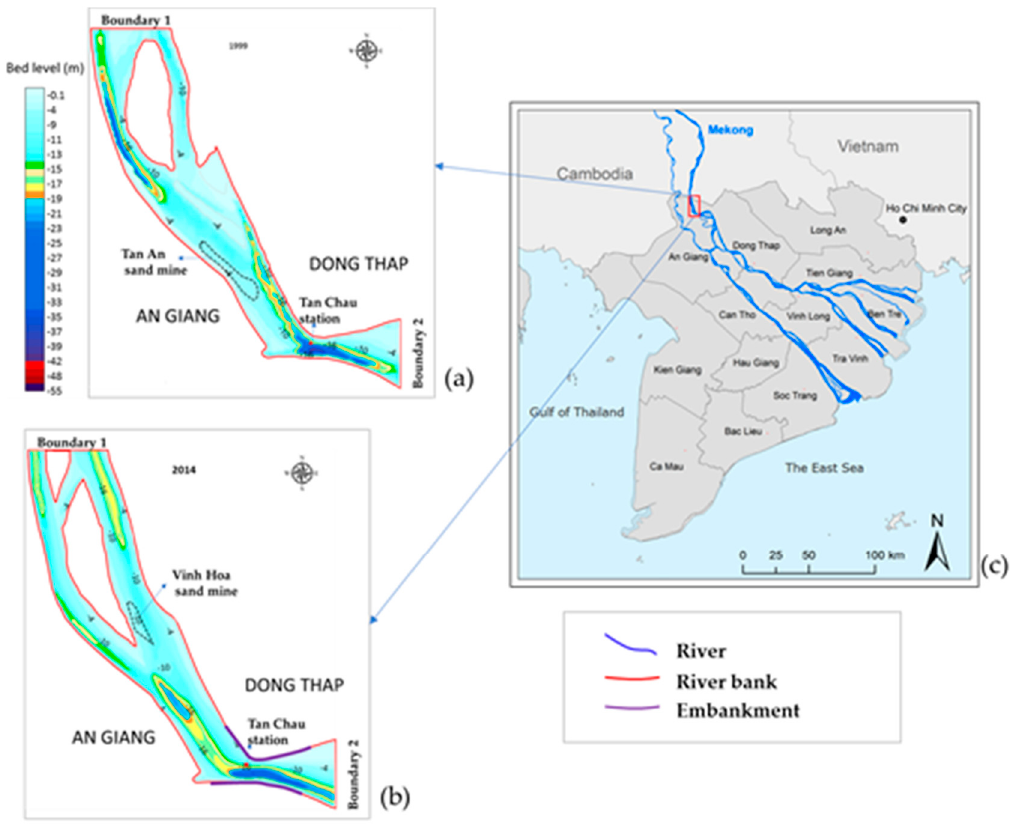
Figure 1. The study area (Source: Tan Chau bathymetry ( a ) collected on October 1999 from the